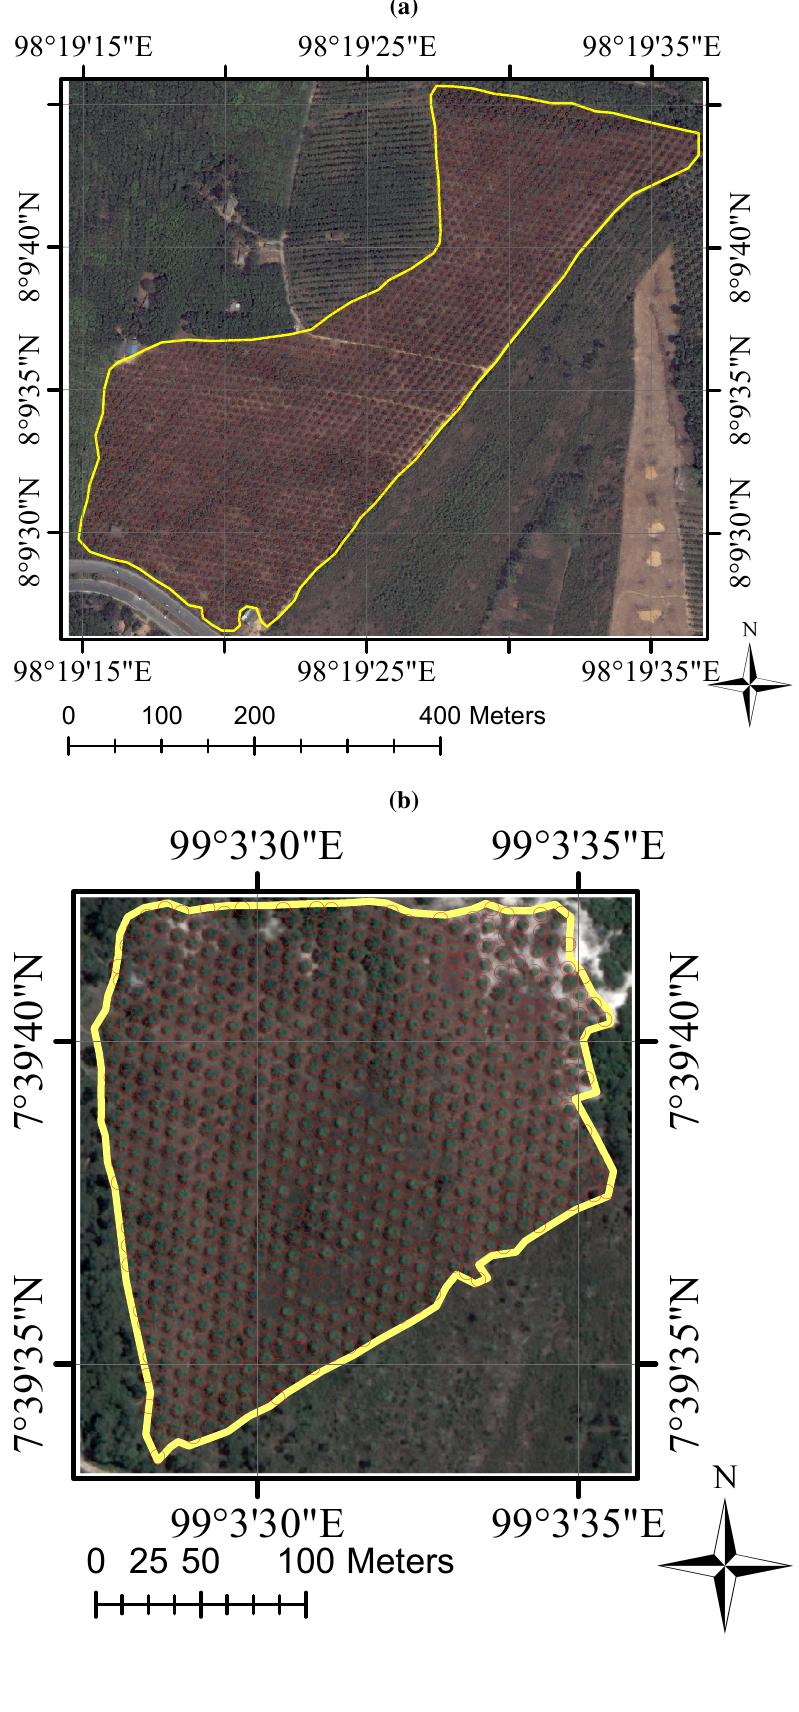
Figure 8. Two examples of detection results from WorldView-2 imagery are illustrated in ( a , b ). The detected oil palm trees from the proposed method are marked with red circles. Note that the diameter of red circles has no relationship with the diameter of tree